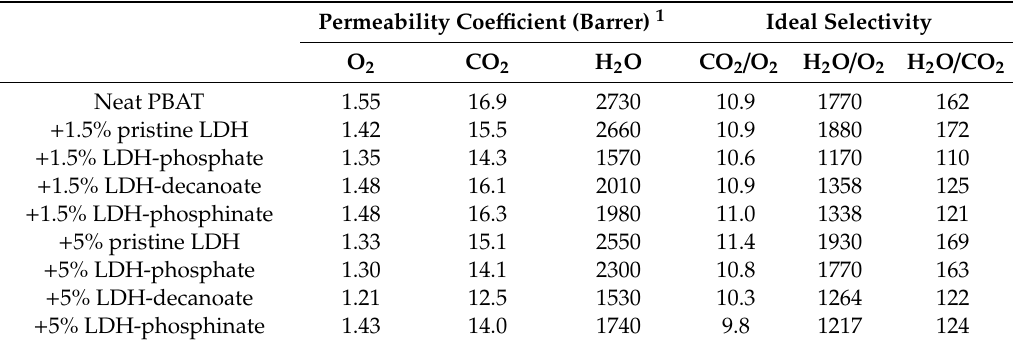
Table 2. Comparison of O 2 , CO 2 , and water vapor permeabilities and ideal selectivities of neat PBAT and PBAT nanocomposites with 1.5 and 5 wt % of pristine LDH, LDH-phosphate, LDH-decanoate, and